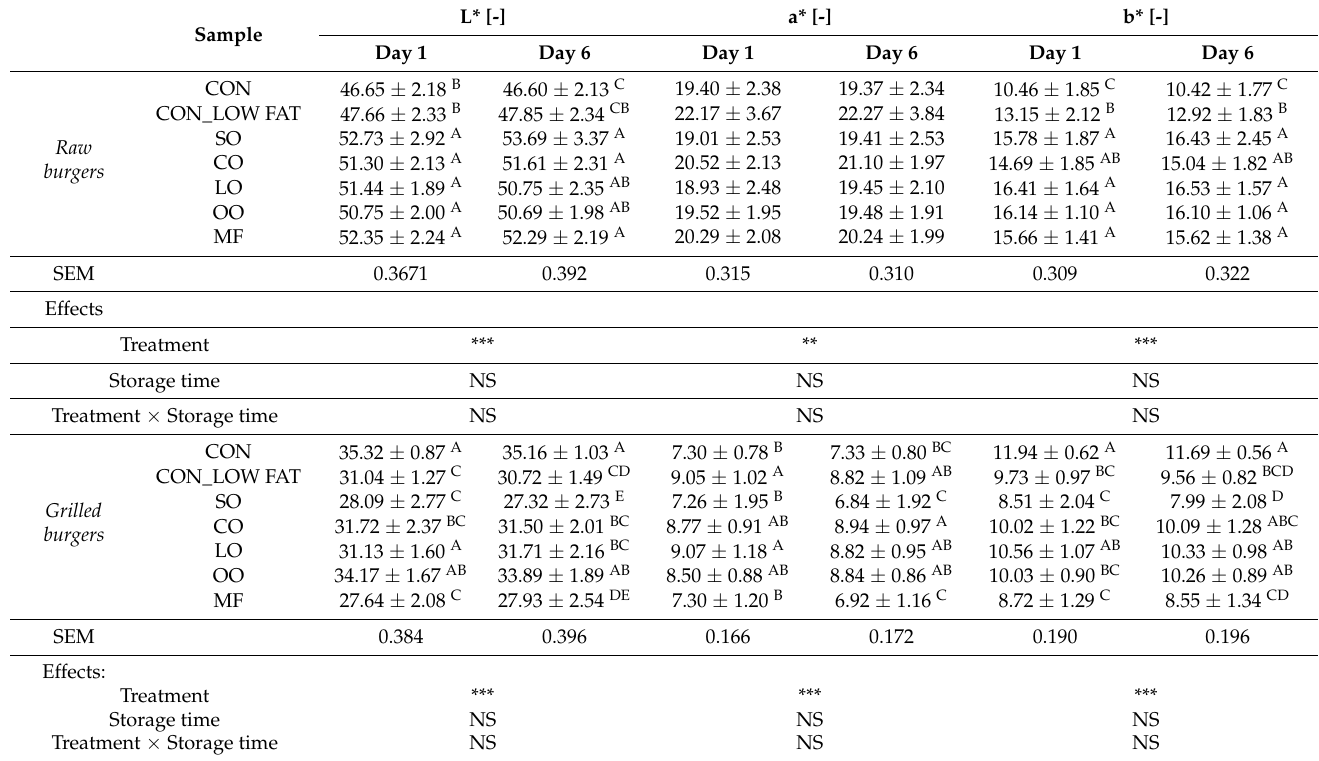
CON—control group beef burgers, CON_LOW FAT—burgers with reduced fat, burgers with fat substitutions, i.e., sunflower oil (SO), canola oil (CO), linseed (LO), olive oil (OO) and milk fat (MF). ( A–E )—means with